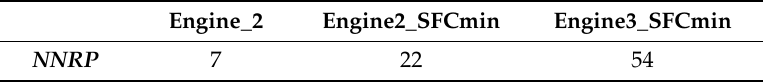
Table 10. Number of non-revenue passengers due to the battery pack.